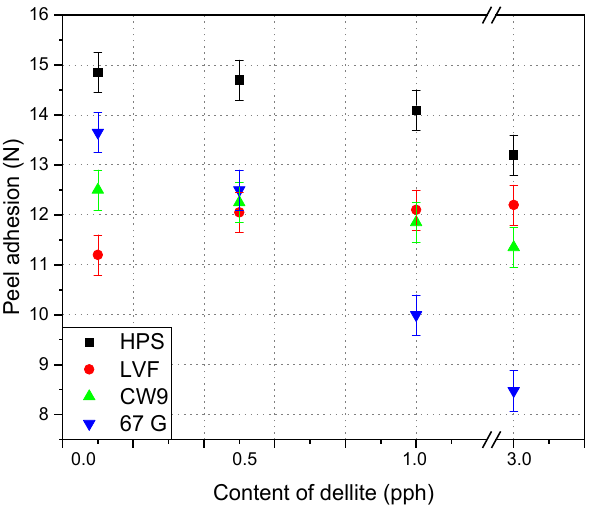
Figure 3. Effect of contents of dellite addition on the peel adhesion of silicone pressure-sensitive adhesives.